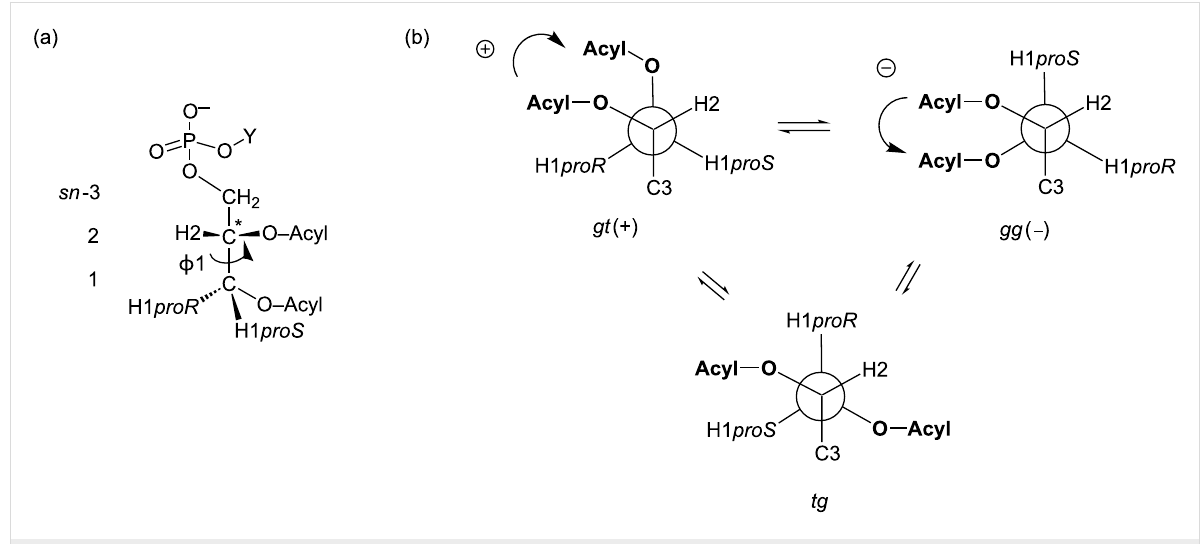
Figure 1: (a) Structures of cell-membrane glycerophospholpids with a common asymmetric 1,2-diacyl- sn -glycerol-3-phosphate structure and (b) the conformational equilibrium among three staggered conformers, namely gt(+), gg( − ) and tg around the 1,2-diacyl moiety.